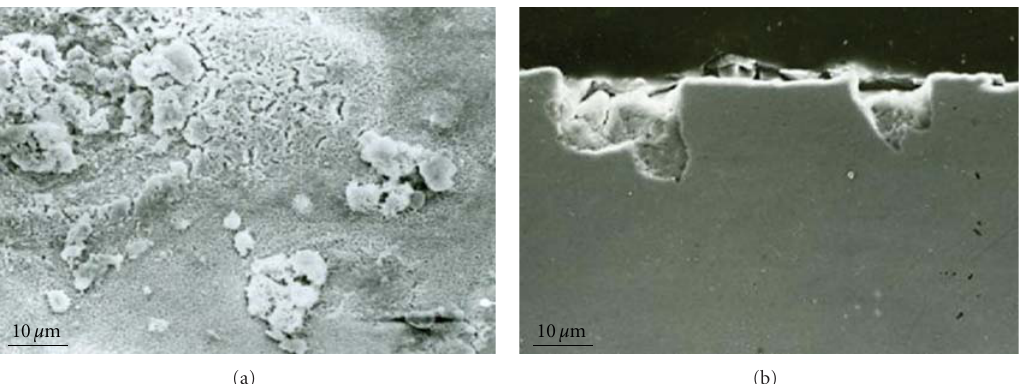
Figure 5: Morphology of corrosion product layers formed on zinc in unpolluted atmospheres: (a) Villa Martelli (surface view) and (b) La Plata (cross-section